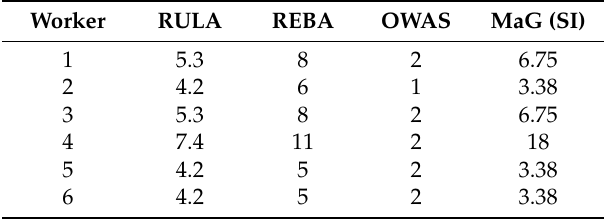
Table 6. Evaluation results for the four modules shown in the paper.